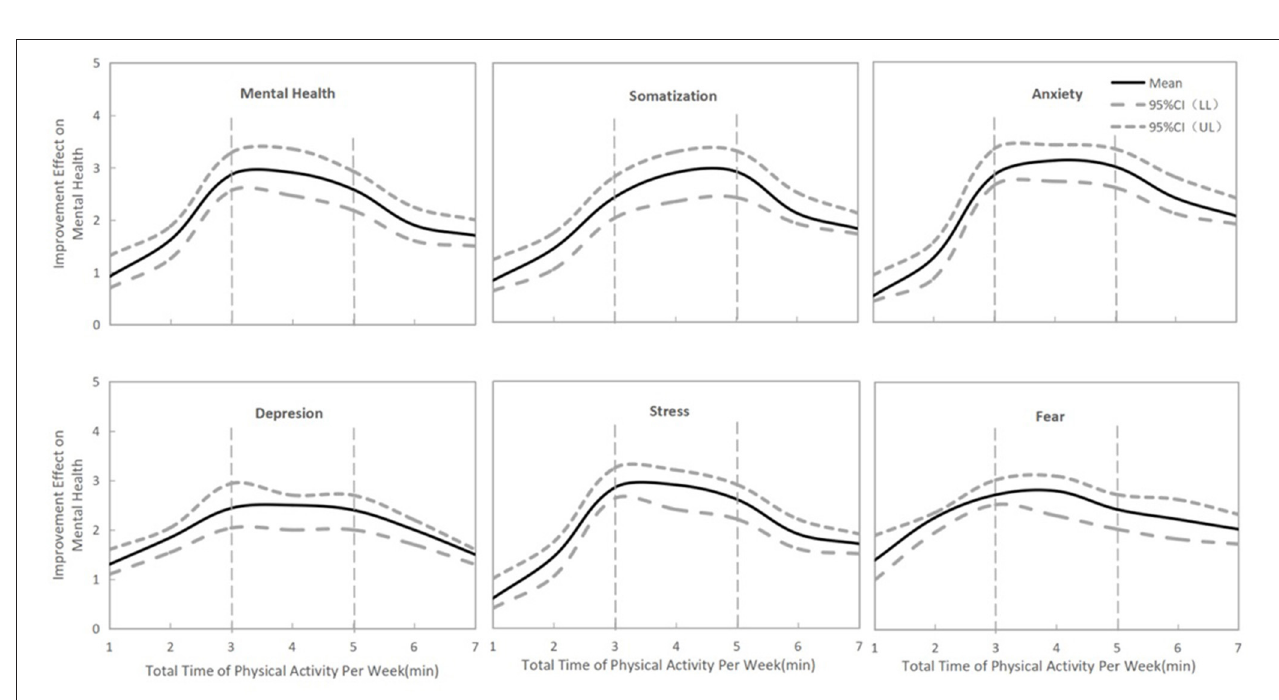
FIGURE 6 | The association between mental health improvement and exercise frequency per week.